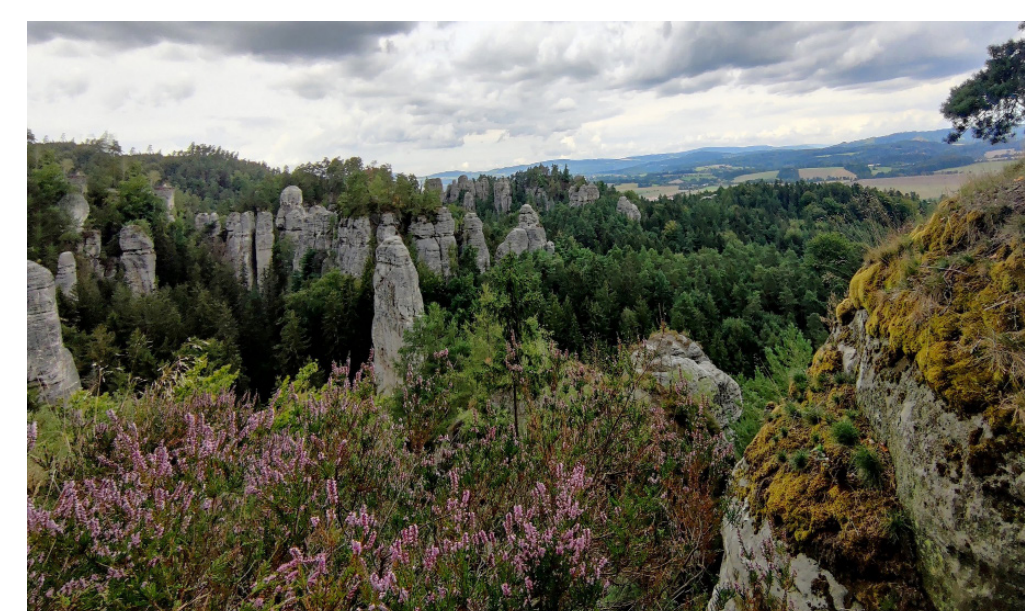
Figure 3. Beautiful Landscape Sample characterizing the Bohemian Paradise UGGp. Upper Cretaceous sand- stones. Excursion site of the 4GEON